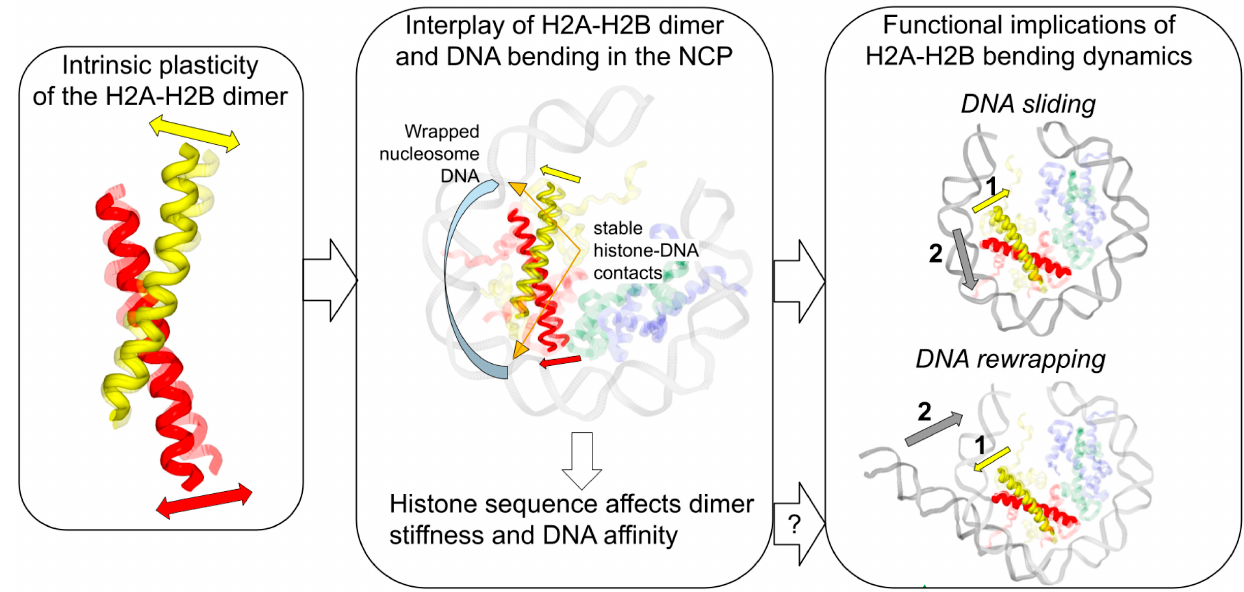
Figure 6. Functional implications of H2A-H2B dimer